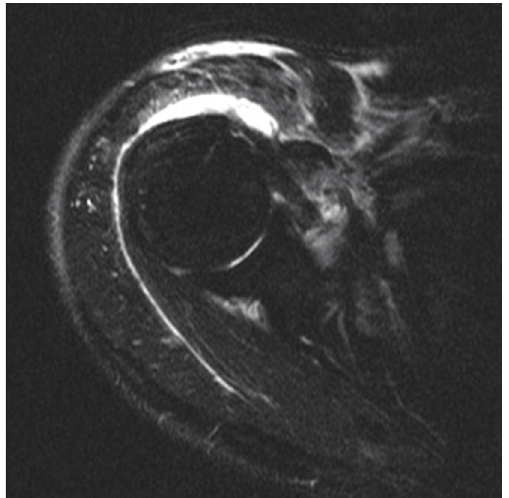
Figure 2: Axial T2-weighted MRI scan showing collection in anterior aspect of subacromial